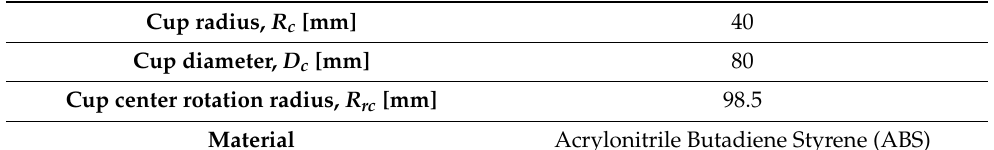
Table 1. Characteristics of the rotor used for the TASEC-Lab mission.